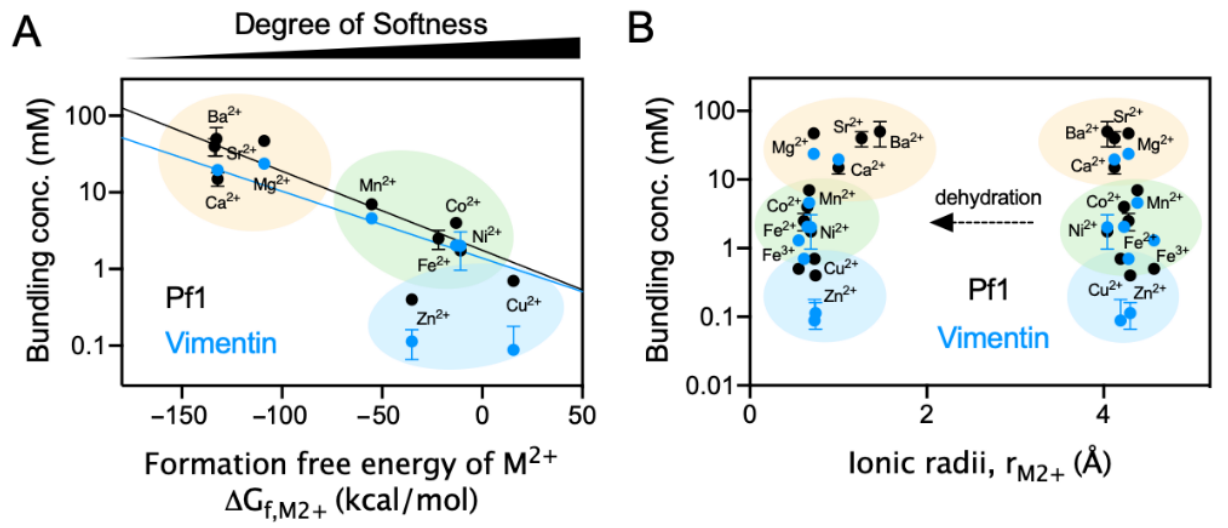
Figure 4. Critical bundling concentrations of different cations for both Pf1 and VIFs correlate with the metal ion softness but not their radii. ( A ). The critical bundling concentrations of different metal ions linearly correlates with the Gibbs free energy of the formation of metal ions, a natural index of Lewis acid softness. ( B ). The trends in the critical bundling concentrations could not be explained by the size effect of the metal ions. The hydrated radii of the metal ions are shown on the right and the naked ionic radii are shown on the left. The beige color on both panels highlights the alkaline earth metals; the light green and blue color highlight the early and late transition metals in the same period,